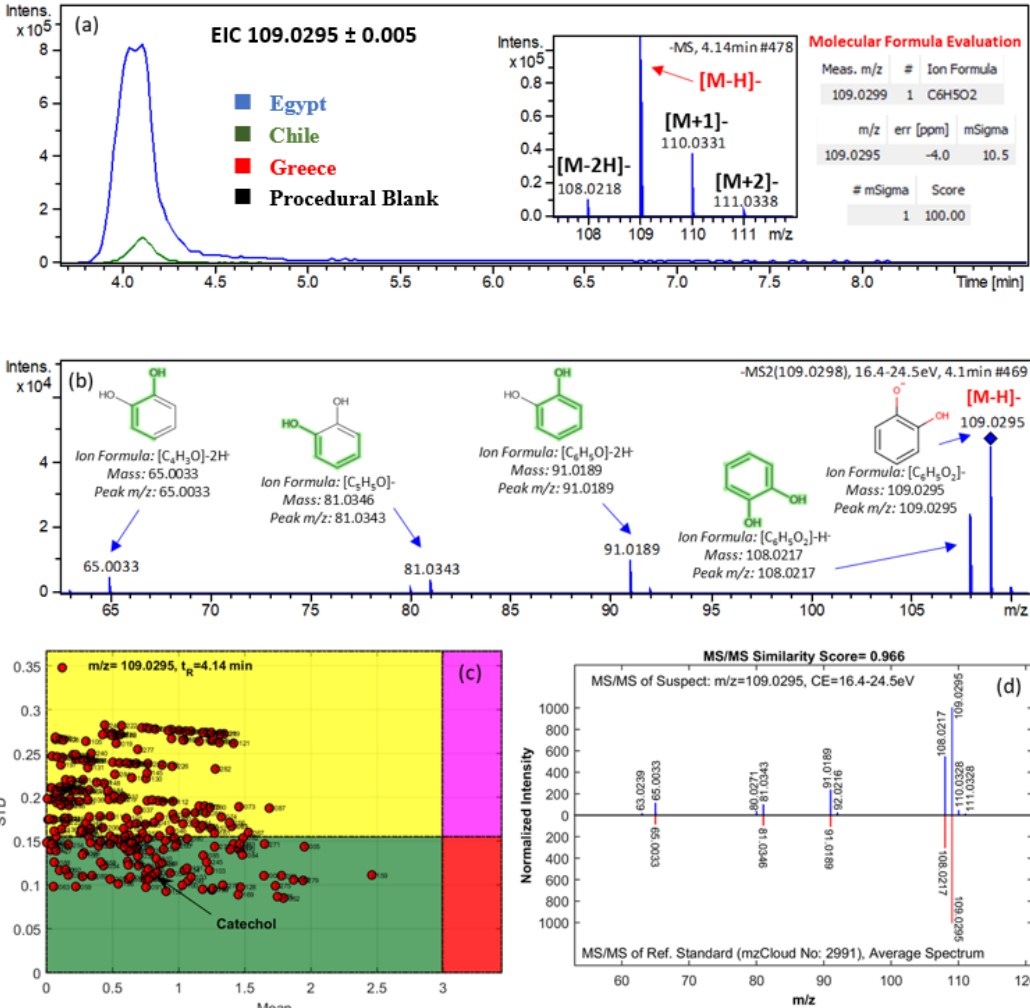
Figure 4. Identification of catechol : ( a ) fullscan Mass Spectrometry (MS) chromatogram and Extracted Ion Chromatogram (EIC) for the given mass ( ± 5 mDa); ( b ) MS / MS spectra and corresponding fragments; ( c ) Monte Carlo Sampling (MCS) plot for evaluating the predicted t R values; ( d ) confirmation step using MS2 spectra of reference standard from the spectrum library.